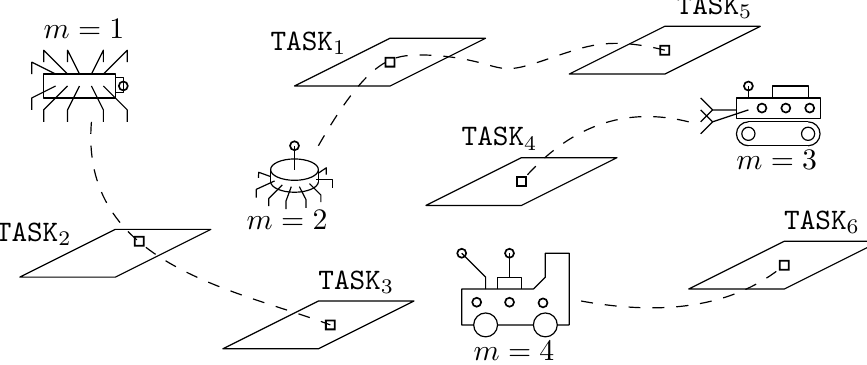
Figure 1. Schematic diagram of the considered scenario for M = 4 robots and a mission composed by N = 6